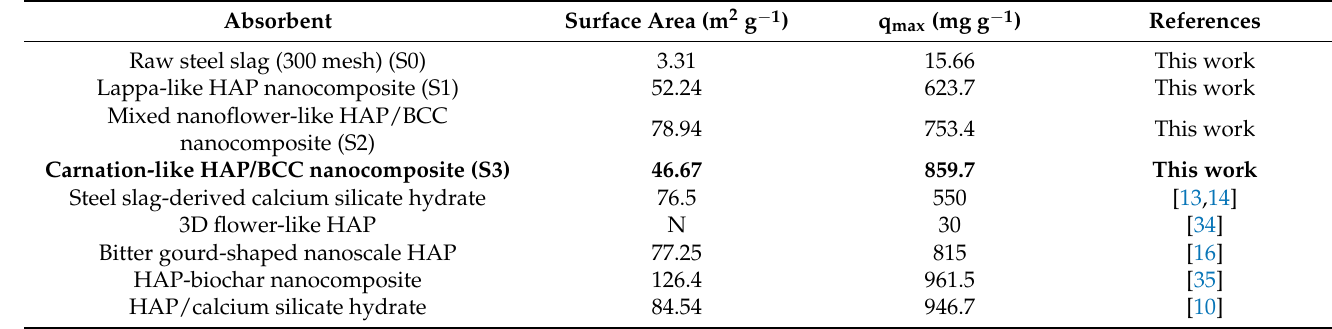
Table 2. Comparison of the adsorption capacities of Pb 2+ on steel slag-based materials or HAP materials.